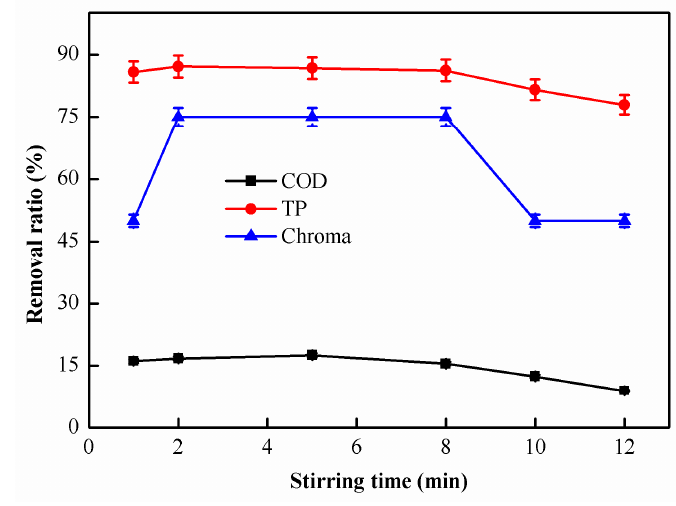
Figure 6. Effect of stirring time on coagulation performance.